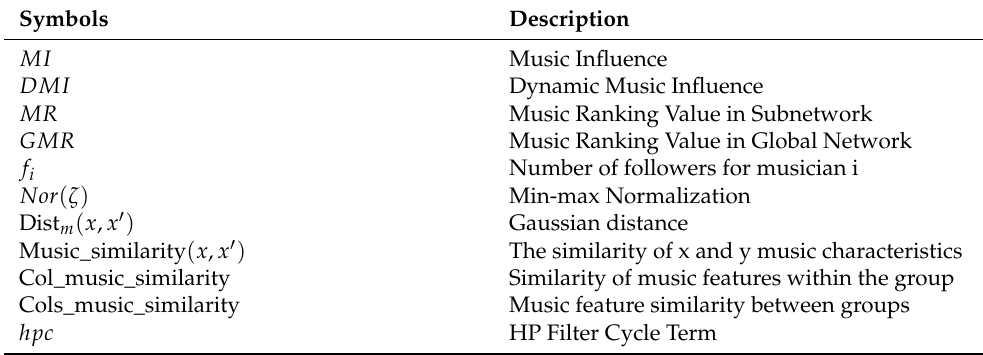
Table 1. Major symbol